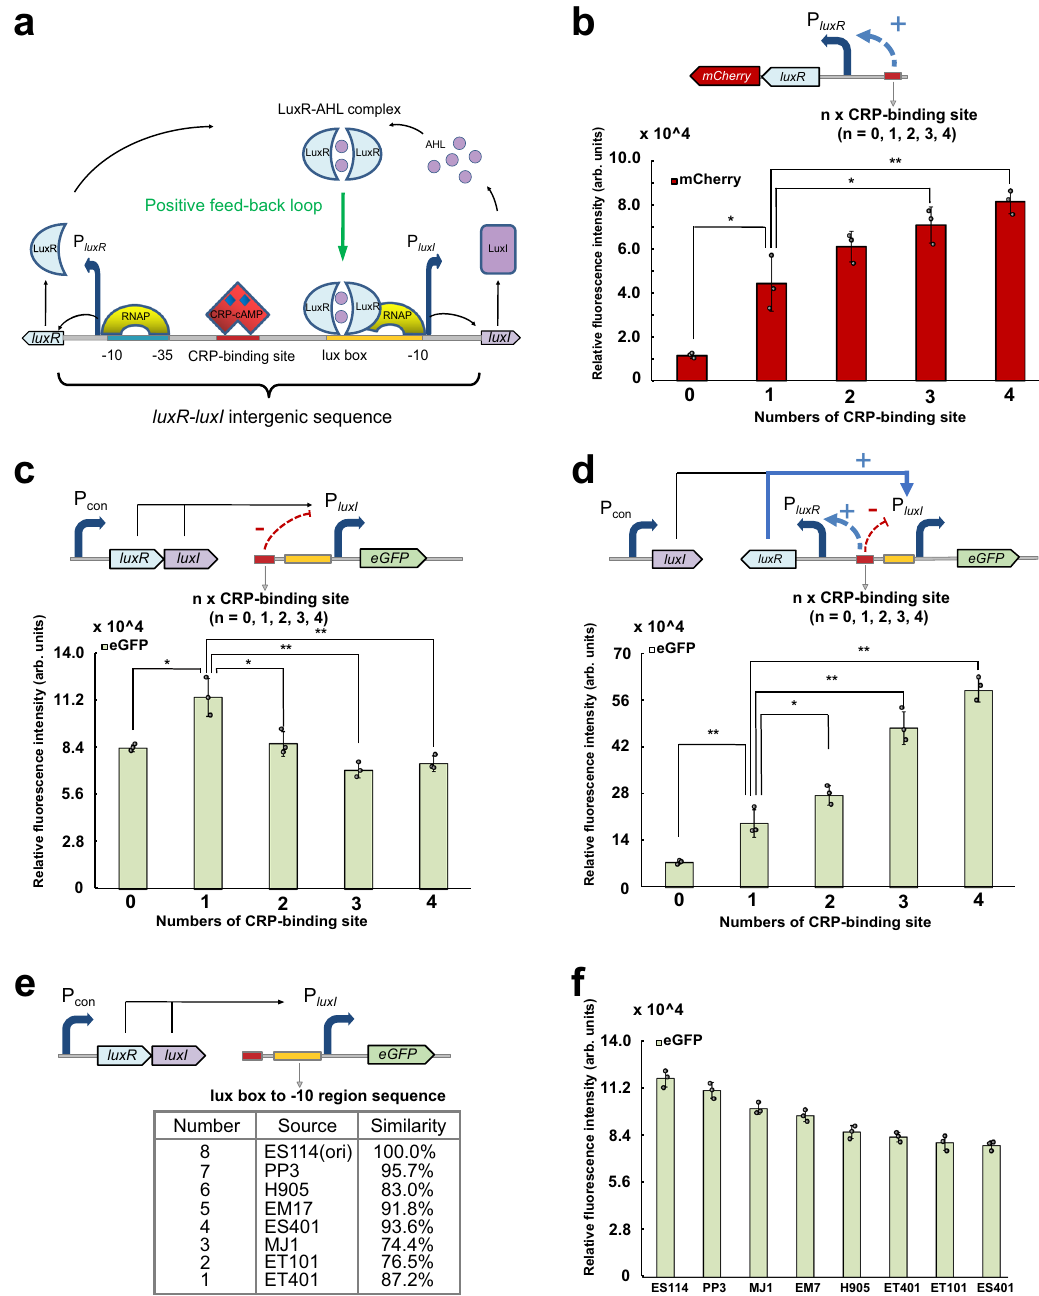
Fig. 1 Investigation of the regulatory mechanism of luxR-luxI intergenic sequence. a Schematic diagram of the Lux-type QS system. b The strength of P luxR promoter with tandem copies of CRP-binding site ( n = 0, 1, 2, 3, 4). P values: 0.01, 0.11, 0.04, and 0.01. c The strength of P luxI promoter with tandem copies of CRP-binding site ( n = 0, 1, 2, 3, 4). The genes luxR and luxI were expressed under the control of a constitutive promoter. P values: 0.01, 0.02, 0.03, and 0.05. d The strength of P luxI promoter with tandem copies of CRP-binding site ( n = 0, 1, 2, 3, 4) in the presence of P luxR controlled LuxR. The gene luxI was expressed under the control of a constitutive promoter. P values: 0.01, 0.04, 0.00, and 0.00. e The sources of the “ lux box ” to “ − 10 ” site sequence and their sequence similarity with ES114. f Fluorescence intensity of each P luxI promoter with different “ lux box ” to “ − 10 ” site sequence. The genes luxR and luxI were expressed under the control of a constitutive promoter. AHL acyl-homoserine lactone, LuxI AHLs synthase, LuxR a transcriptional regulator protein, cAMP cyclic adenosine monophosphate, CRP-cAMP receptor protein, CRP-cAMP a complex of CRP binding to cAMP, RNAP RNA polymerase. Data shown are mean ± SD ( n = 3 independent experiments). The statistical analysis is based on a two-sided Student ’ s t -test. * P < 0.05 and ** P < 0.025. Source data are provided as a Source Data fi